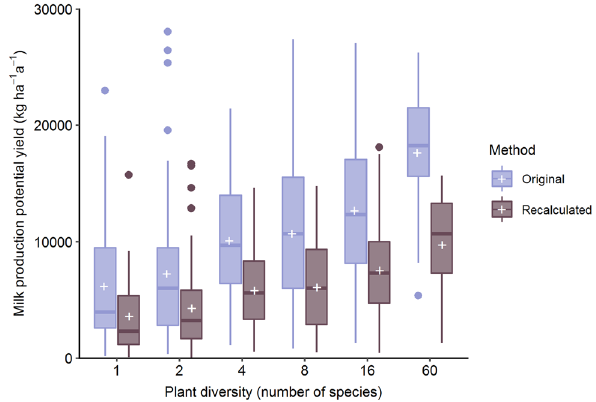
Fig. 2 Bias in calculated milk production potential yield introduced by omitting maintenance energy requirements and daily dry matter intake capacity of dairy cows. Milk production potential yields as calculated in the original paper by Schaub et al. 6 (original), compared to values recalculated to include maintenance energy requirements and daily dry matter intake capacity of dairy cows ( ‘ recalculated ’ ), as a function of plant